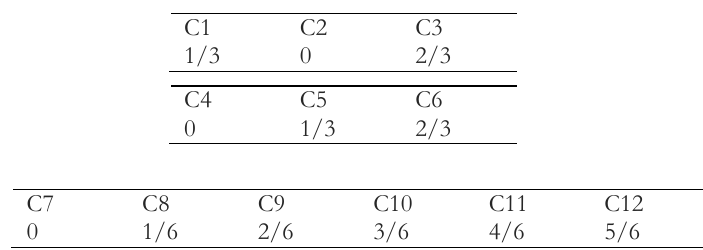
Table1. Contradiction degree of the